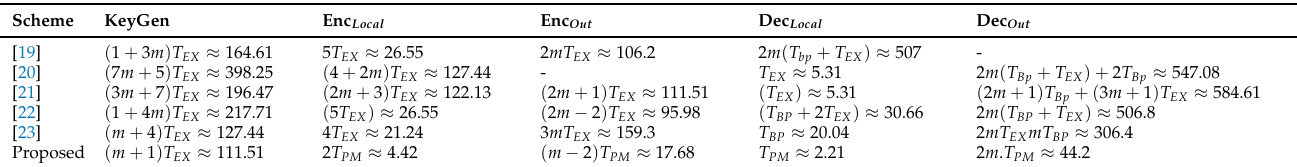
Table 5. Computational overhead (ms).